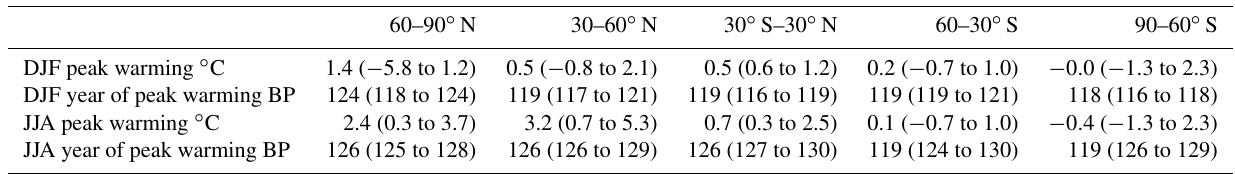
Table 5. Last Interglacial peak warming ( ◦ C) and year of peak warming (BP) compared to the model inter-comparison ± 1 σ ranges of Bakker et al. (2013). Emulated data are provided for December–January–February and June–July–August, compared to January and July data in the model inter-comparison, and comparisons are provided for five latitude bands.